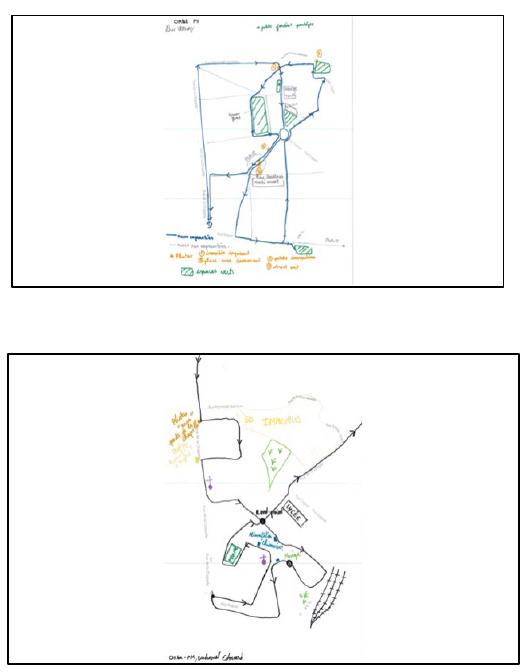
Figure 9. Example of combined